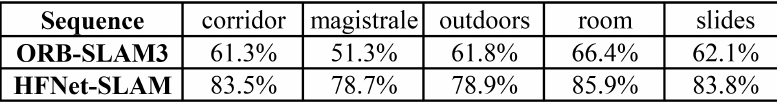
Figure 9. Theaverage precision of feature matching in various environments.